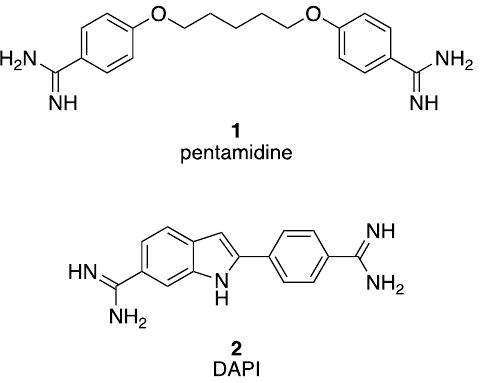
Figure 1. The structure of the anti-parasitic compounds pentamidine 1 and DAPI 2